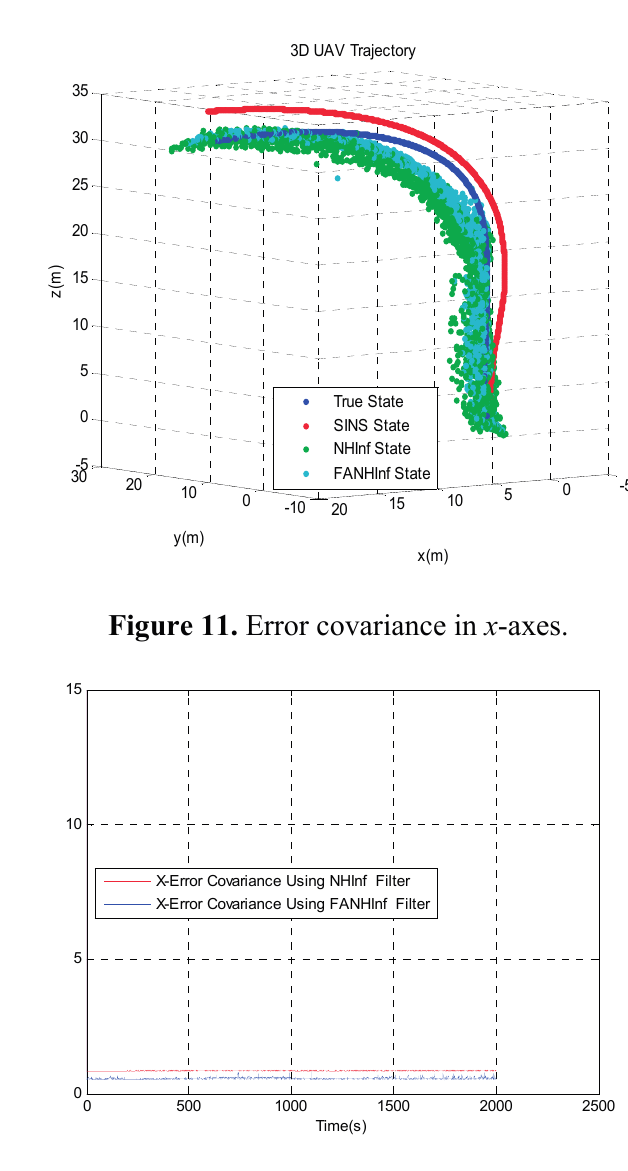
Figure 10. SINS/GPS 3D trajectory estimation.